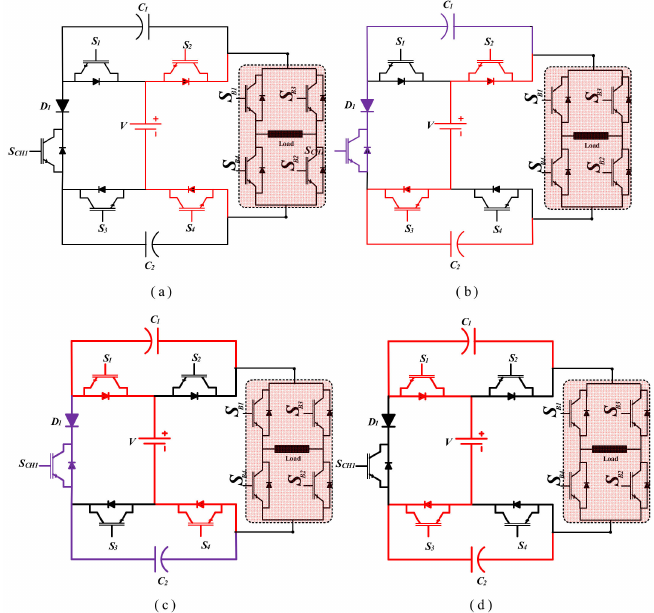
Figure 2. Generation of di ff erent voltage levels of the basic unit at V AN . ( a ) V, ( b ) 2 V ( C 1 in charging state), ( c ) 2 V ( C 2 in charging state), ( d ) 3 V (both C 1 and C 2 in discharging state).